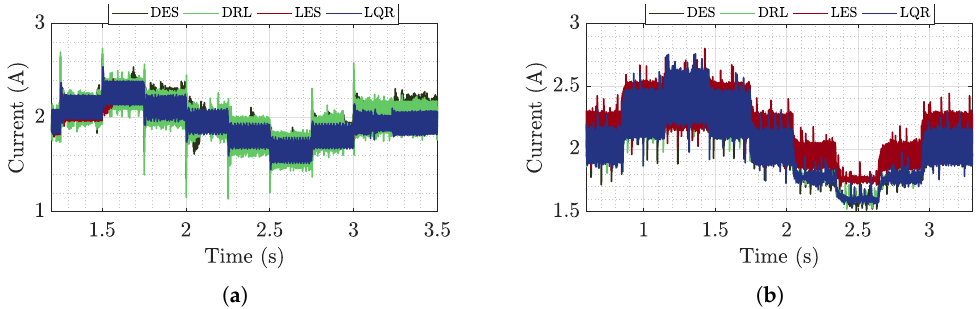
Figure 17. Current in the microgrid buck-buck feeder inductor during the ( a ) simulation and ( b ) test.